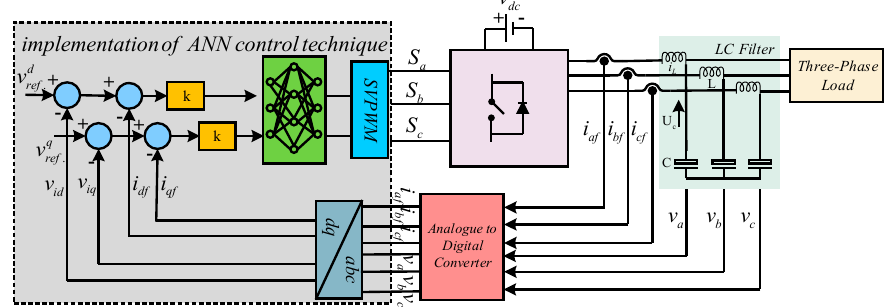
Figure 30. Schematic of Artificial Neural Network control for VSIs.